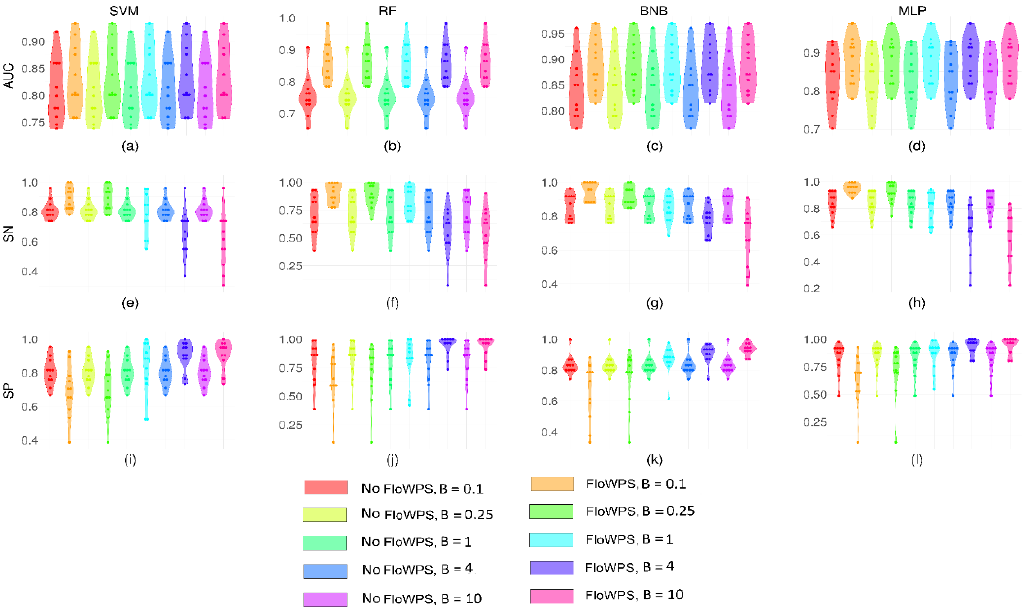
Figure 1. Area under curve (AUC) ( a – d ), sensitivity (SN) ( e – h ) and specificity (SP) ( i – l ) calculated for treatment response classifiers for eleven non-equalized datasets. The classifiers were based on SVM ( a , e , i ), RF ( b , f , j ), binomial naïve Bayes (BNB) ( c , g , k ) and multi-layer perceptron (MLP) ( d , h , l ) machine learning (ML) methods. The color legend shows the absence or presence of FloWPS in the classifier analytic pipeline and the value of relative balance factor B . On each panel, each violin plot shows the distribution of values for eleven cancer datasets. Table 3. Performance metrics for BNB, MLP, RF and SVM methods with the advanced settings for eleven datasets with variable numbers of responders and non-responder samples.